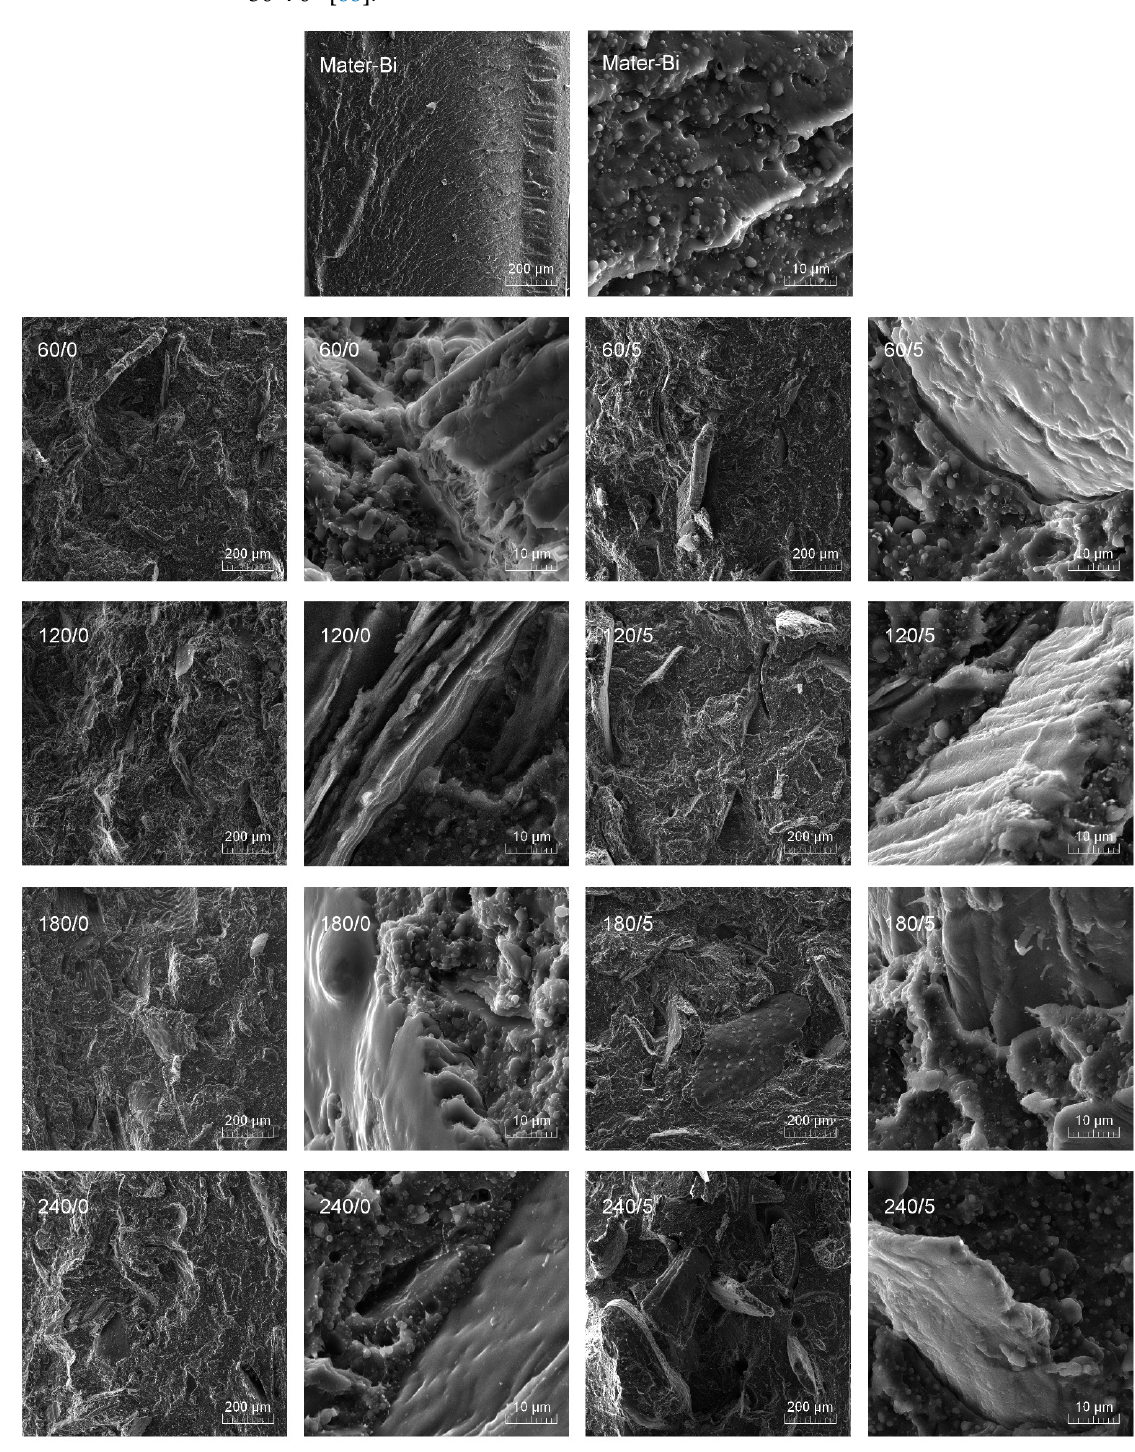
Figure 2. SEM images of Materi-Bi and its composites containing BSG subjected to thermomechanical and chemical treatments; taken with two different magnifications.